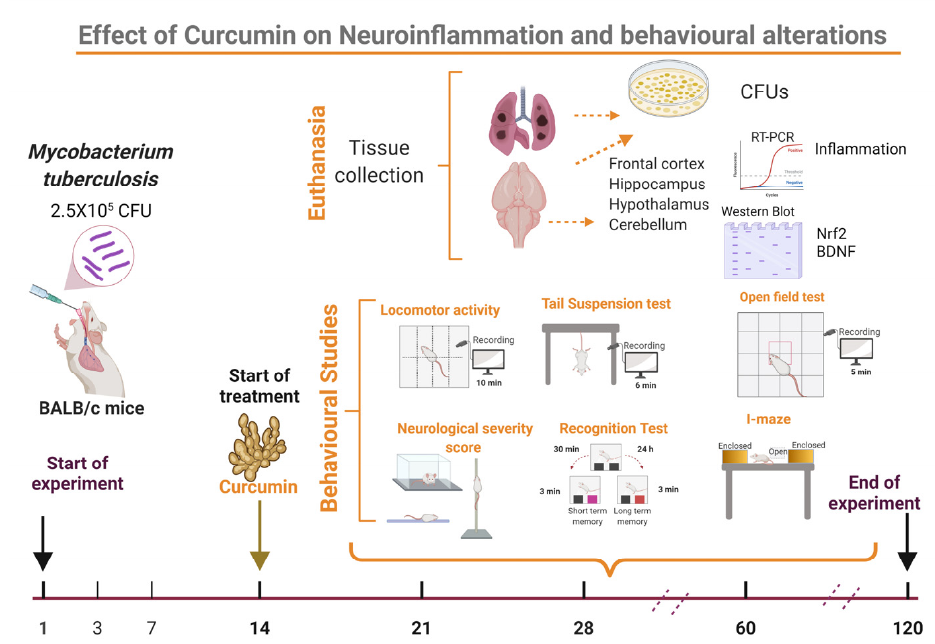
Figure 11. Experimental design to evaluate curcumin (CUR) treatment on neuroinflammation and behavioral alterations of TB mice. The therapy with CUR began on day 14. We administered CUR (16 µ g/mL), and a group received saline solution (SS) as control. Different behavioral assessments were performed on days 21, 28, 60, and 120 after infection. Animals were euthanized after the behavioral tests, and the brain and lungs were taken to assess bacillary burdens. The cytokines gene expression was measured in the hypothalamus, hippocampus, cerebellum, and frontal cortex. Two separate experiments with n = 3 each were carried out for each of the measures. In addition, each experimental age group’s samples were examined individually. (Created with BioRender.com, accessed on 20 January